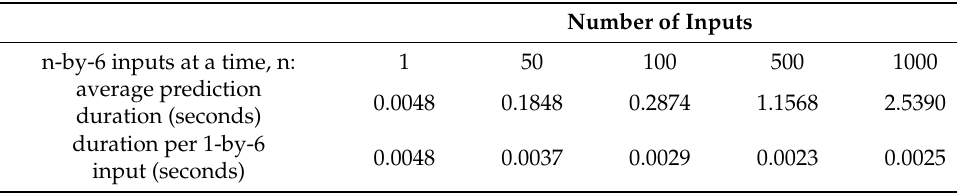
Table 10. Prediction durations of the real-time learning system.